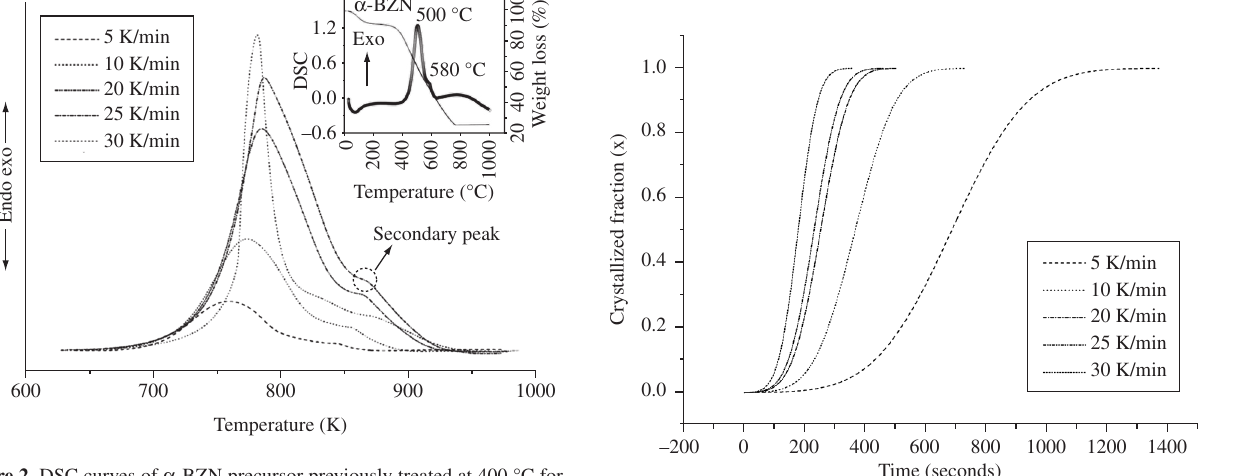
Figure 2. DSC curves of α -BZN precursor previously treated at 400 °C for 2 hours. The circle refers to the crystallization peak. The heating rates are indicated in the figure.